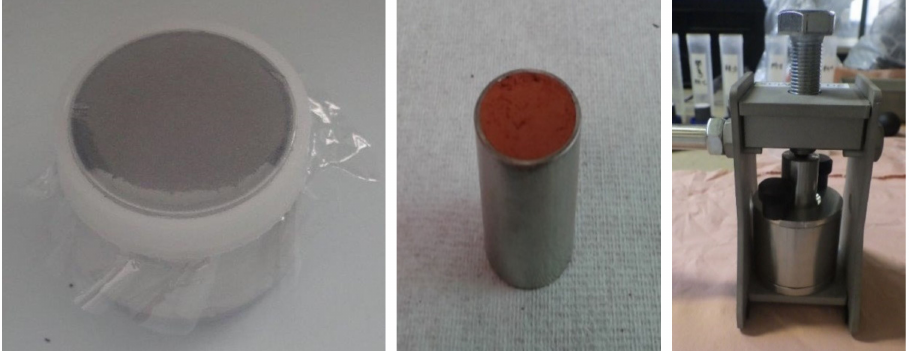
Figure 8. Sample prepared as a cup with film ( left ) or with a press, without film ( centre ) and press ( right